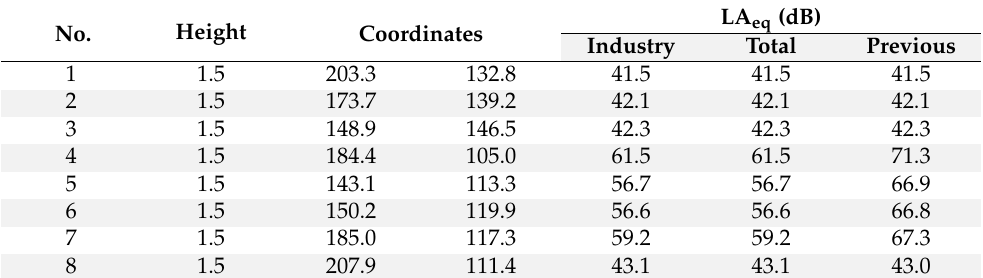
Figure 16. Colour map of isophone bands after considering acoustically significant elements with construction site fencing and a solid gate for the concreting of foundations in the investigated area, with the position of machines inside the construction site. Table 19. Table of points from the calculation of measured points for the concreting of foundations with construction site fencing and a solid gate in the investigated area, with the position of machines inside the construction site.